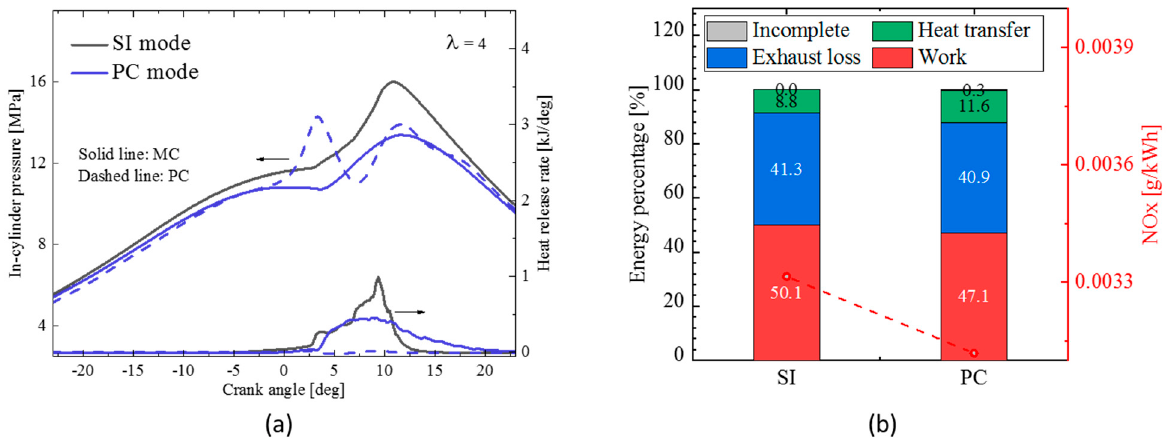
Figure 20. Predicted ( a ) in-cylinder pressure and heat release rate traces and ( b ) efficiency for SI mode (CR = 14.5 and ST = − 8°) and passive PC mode (CR = 14 and ST = − 3°) using λ = 4.